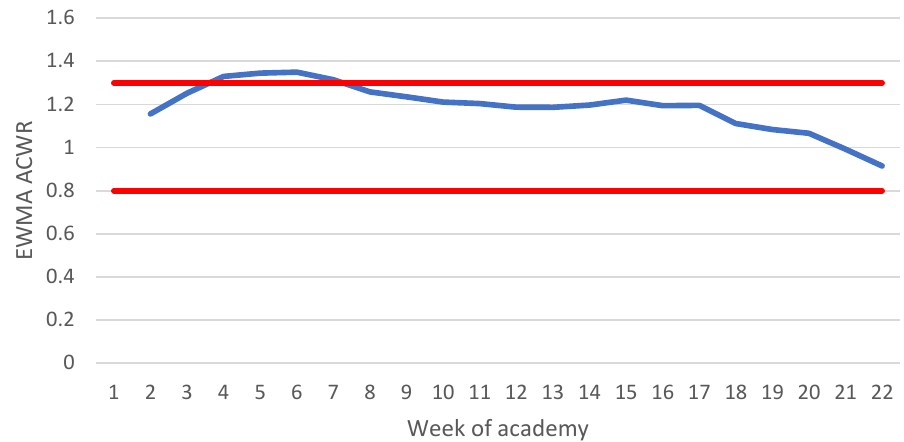
Figure 4. Average ACWR of distance covered across seven academy classes. Key: Red lines signify 0.80–1.30 optimal range as proposed by Gabbett [20]; ACWR, acute:chronic workload ratio.